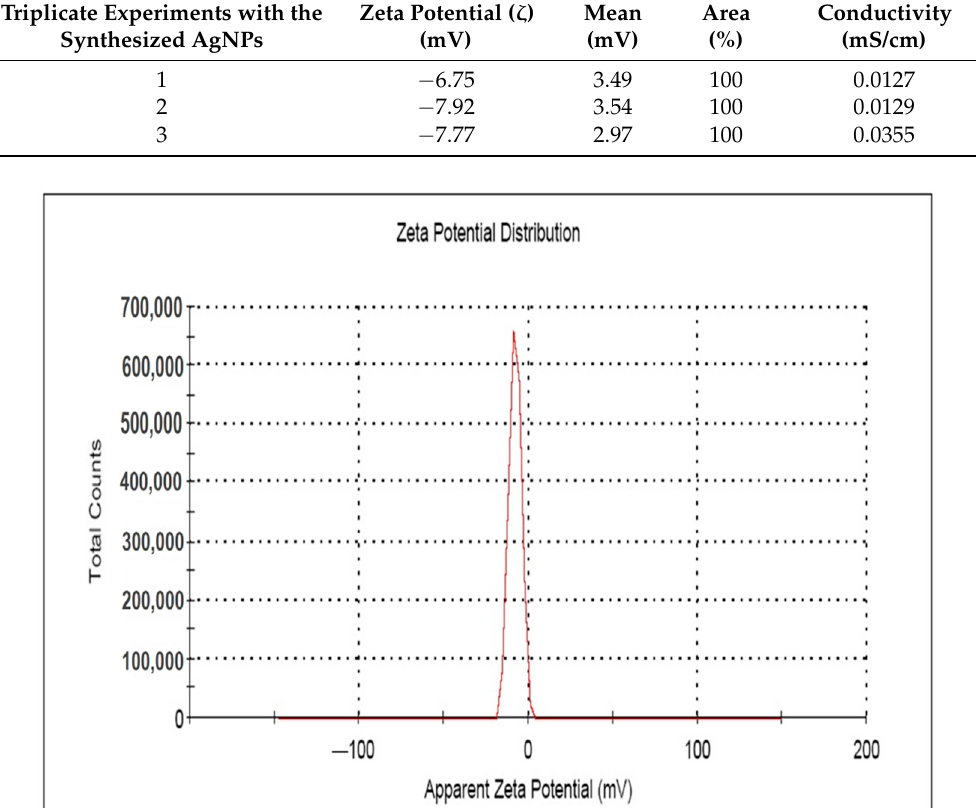
Figure 6. Zeta potential image of the synthesized AgNPs.